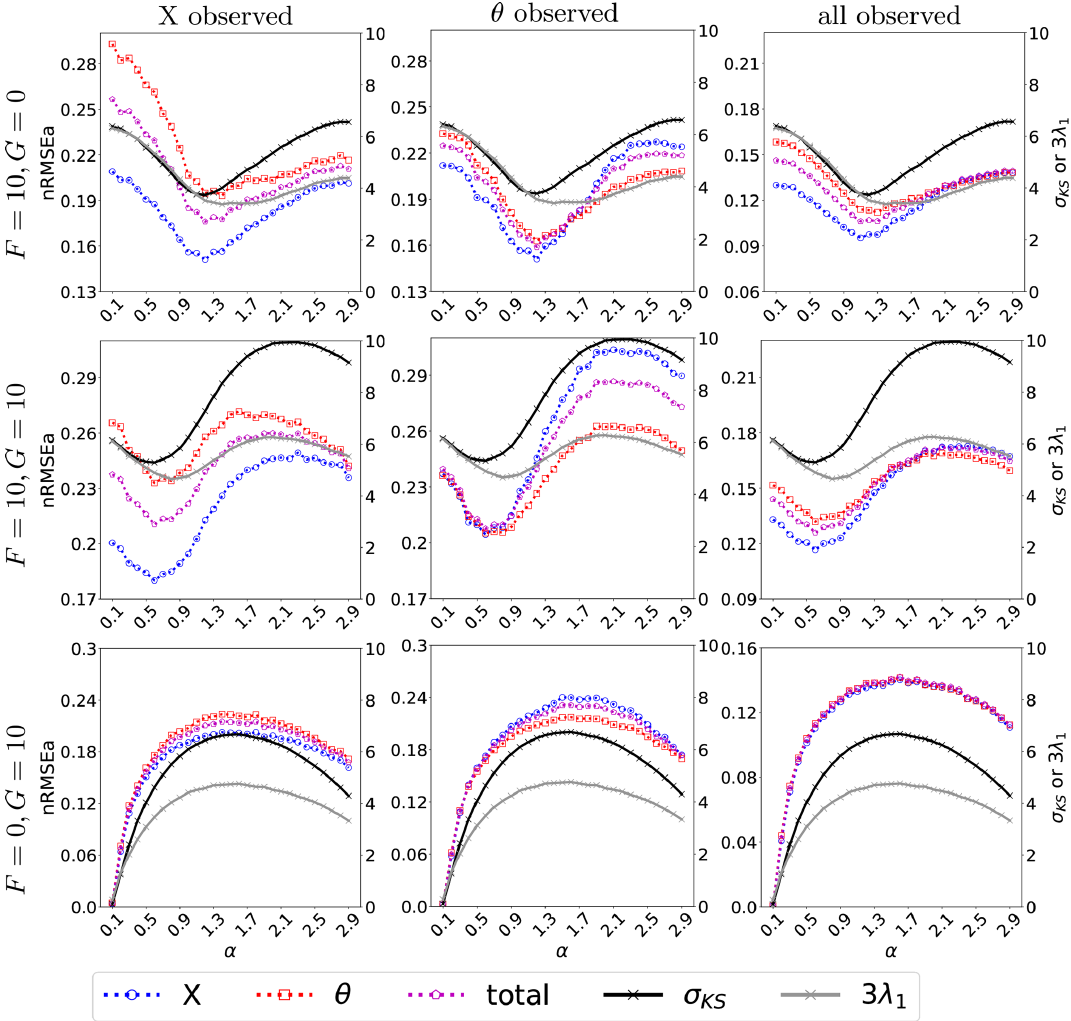
Figure 3. The nRMSEa with varying energy transfer coefficient α ∈ ( 0 , 3 ) (with an interval of 0.1) and dissipation coefficient γ = 1. The left axis represents nRMSEa, while the right axis shows the σ KS and the λ 1 (solid grey line) scaled by a factor of 3. The results come from perfect model assumption with observations at each time step where all variables, only X , or only θ is observed. The dashed blue line indicates the nRMSE of the X variable, the dashed red line represents the nRMSE of the θ variable, and the dashed purple line shows the nRMSE of the entire state